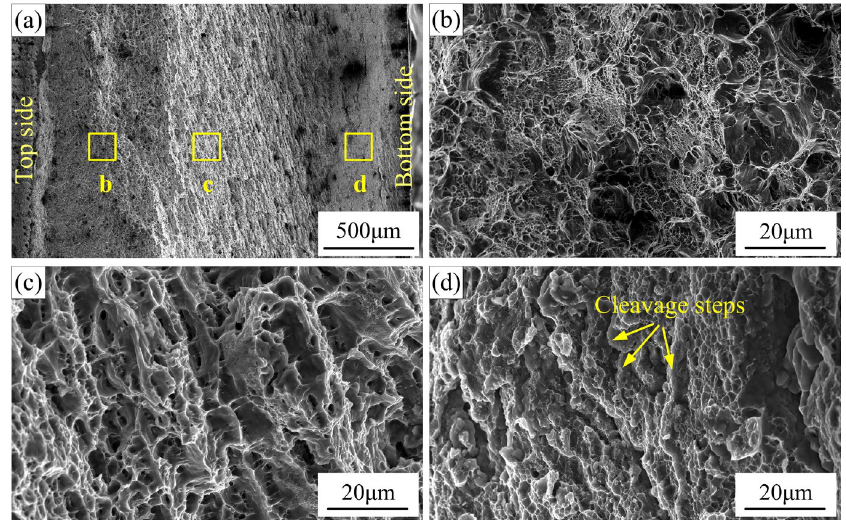
Figure 17. Typical fracture surface morphology of the joint: ( a ) macro-morphology; ( b – d ) magnified morphologies of the areas b, c, and d in ( a ); ( ω = 900 rpm, v = 30 mm/min, d = 12 mm).